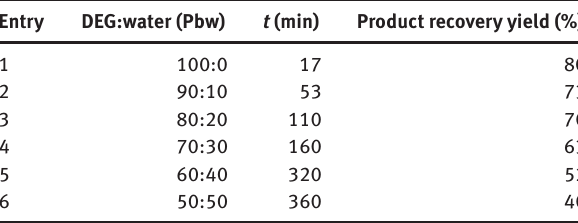
Table 2: DEG/water composition role using micro-TiO support in chemical recycling of PC